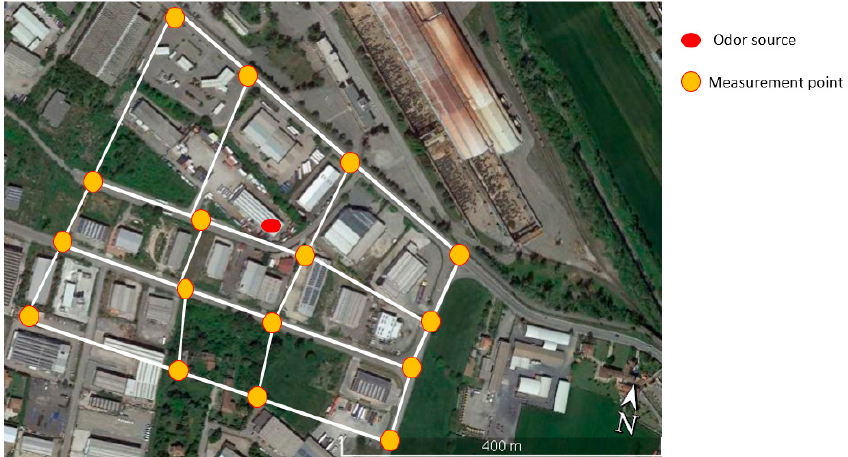
Figure 7. Example of an assessment area in the surroundings of an odor emission source with assessment squares and measurement points.